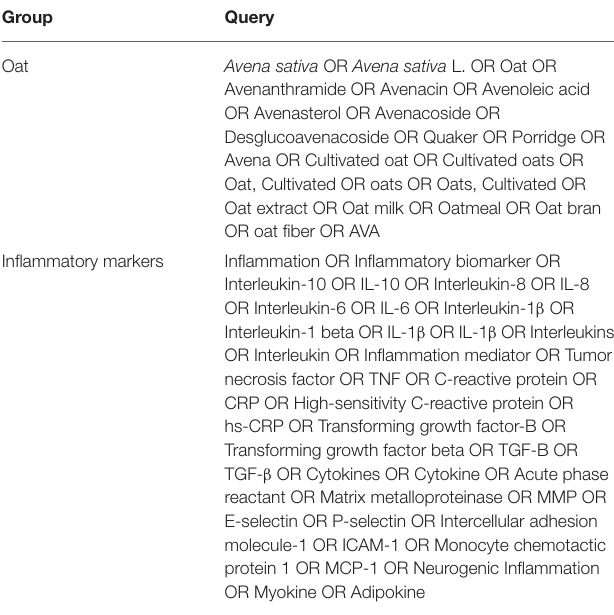
TABLE 1 | Queries for the literature search.